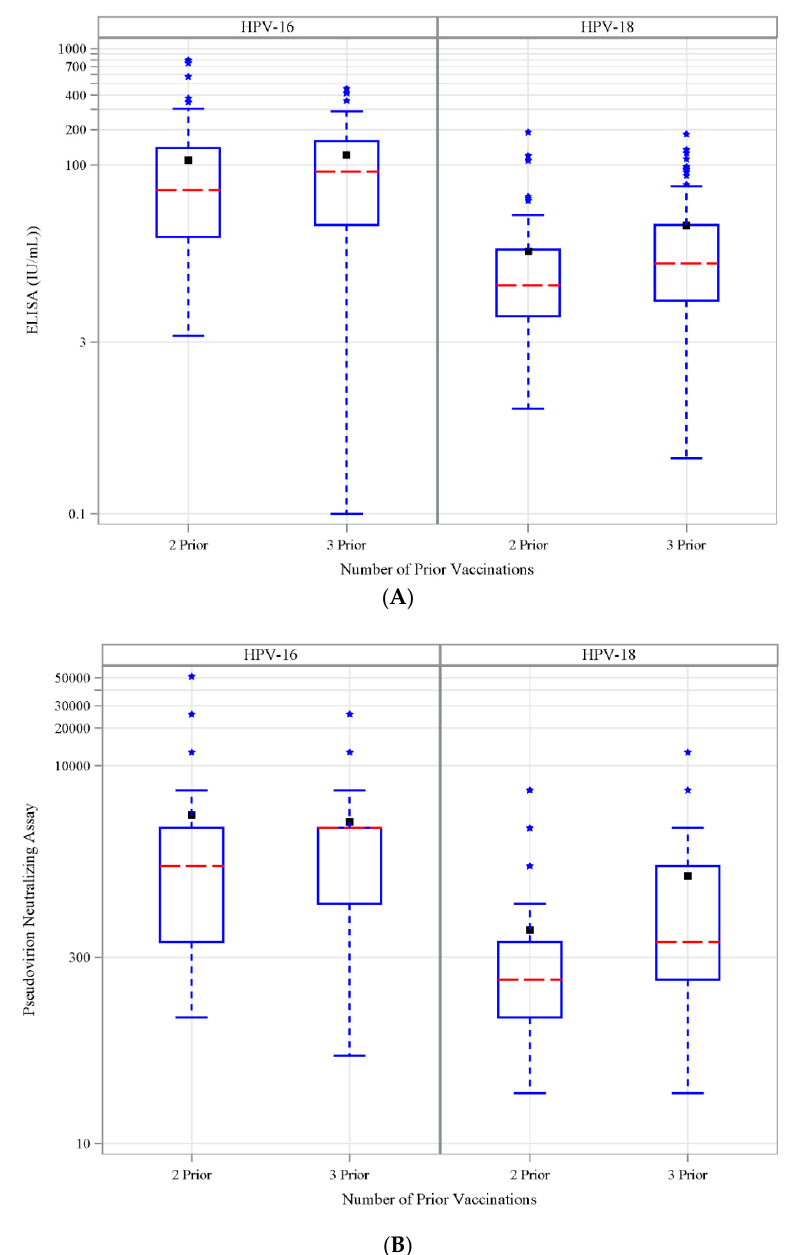
Figure 4. Antibody levels in retrospective cohort. (A) HPV-16- (left panel) and HPV-18-specific (right panel) ELISA Ab titers (IU/mL) and (B) pseudovirion neutralization titers in retrospective cohort with 2 or 3 doses of prior 4vHPV vaccination.